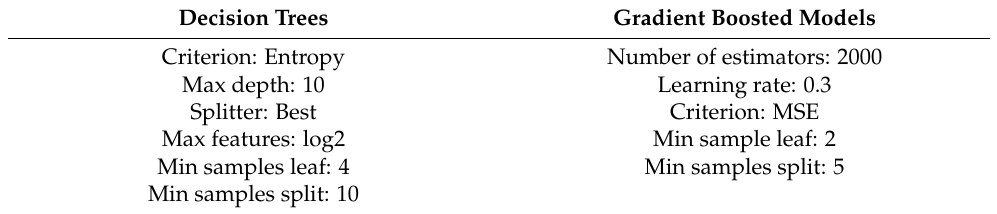
Table 2. Parameters of